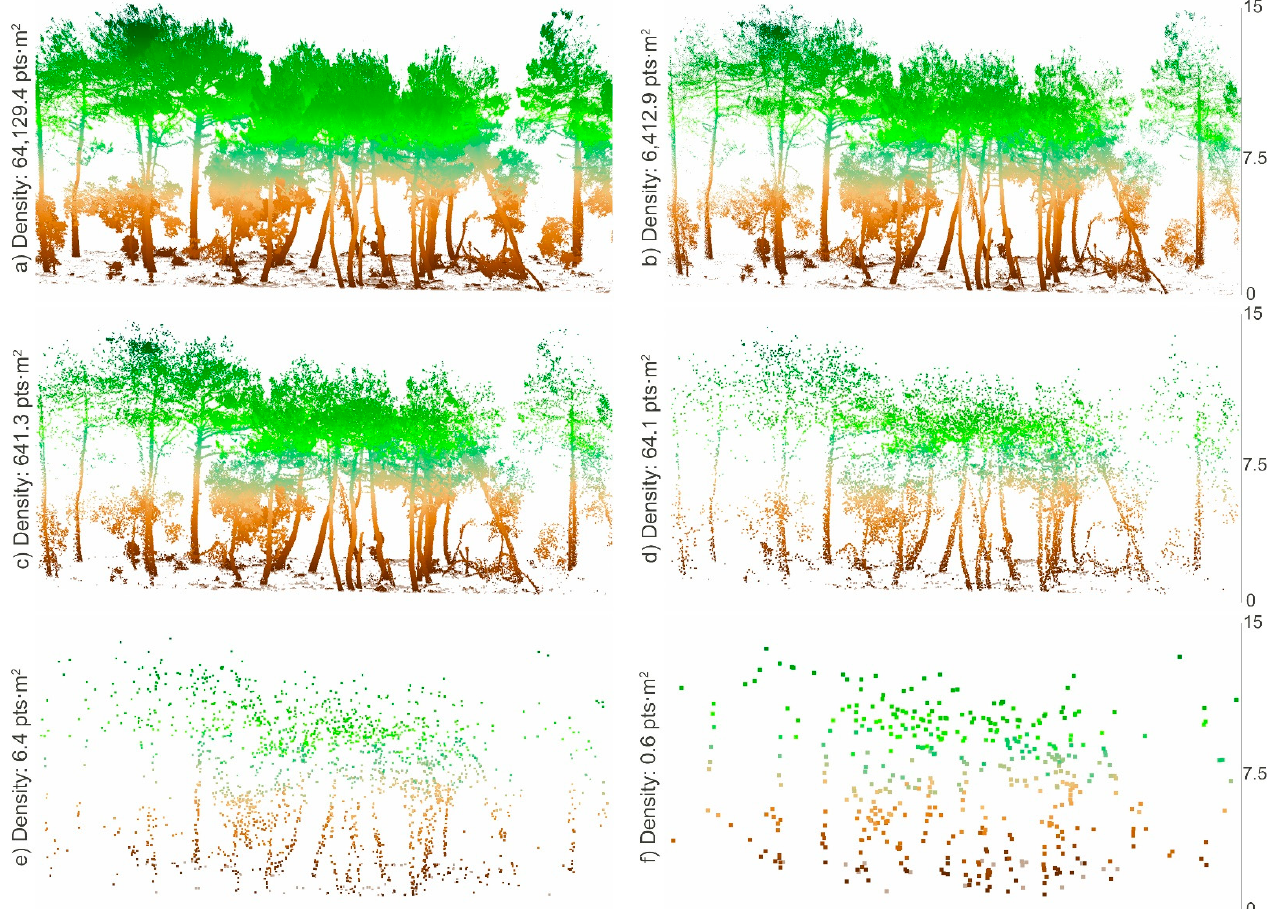
Figure 4. Effect of the progressive random reduction in the TLS point clouds over a profile with a 30 m length (central axis of the circular plot) by 10 m wide, resulting in an area of 296 m 2 . The image sequence ( a – f ) shows the point density in the Y -axis and corresponds to plot n ◦ 28 (mixed forest), specifically to the combination of scans 0-5-6-7-8.